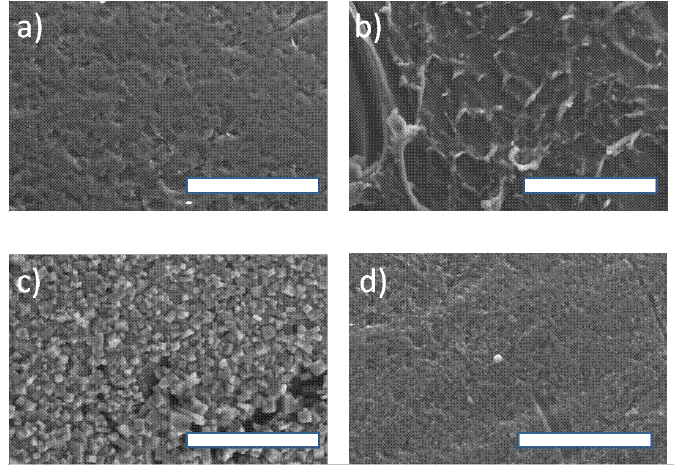
Figure 6. FE-SEM images of the Nafion NR50 surface morphology obtained from: ( a ) pristine Nafion; ( b ) the reaction without salt; ( c ) with salt after one catalytic run; ( d ) after regeneration in concentrated HCl solution (scale bar = 50 µ m).